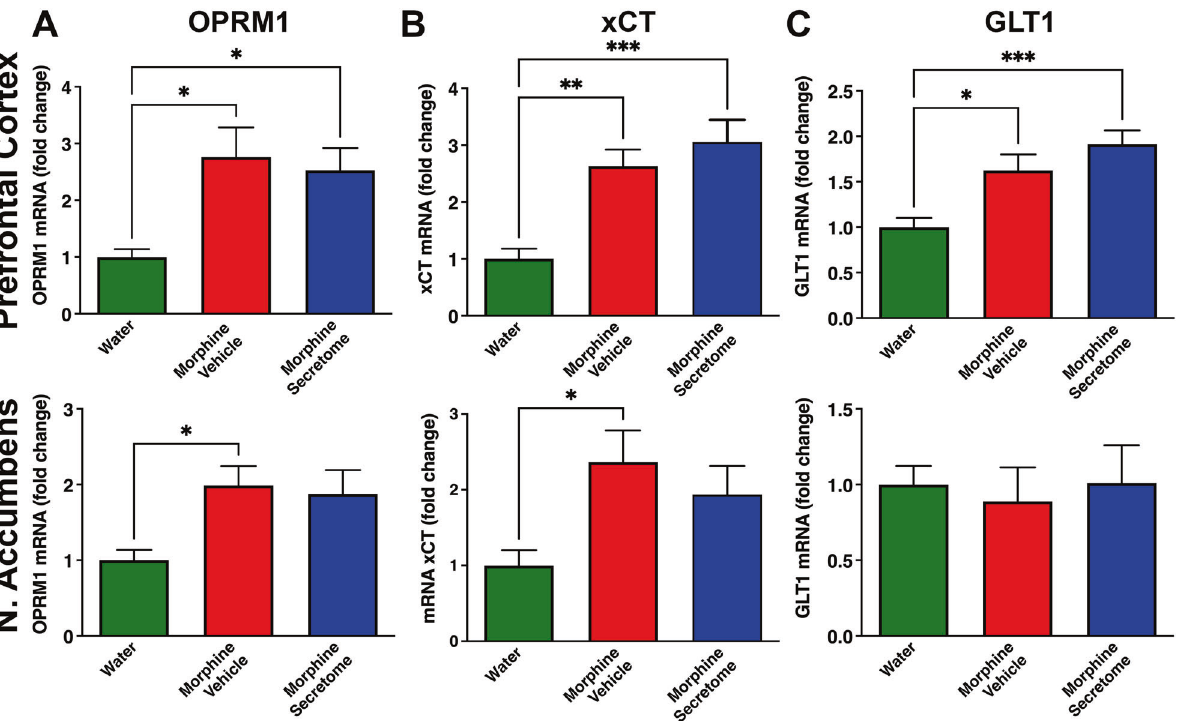
Fig. 3 Simultaneous intranasal and intravenous administration of secretome derived from human preconditioned MSCs to Wistar did not modify the morphine-induced increases in the brain expression of μ -opioid receptor or glutamate transporters. Quanti fi cation of the mRNA levels of the ( A ) μ -opioid receptor OPRM1; ( B ) xCT glutamate transporter and ( C ) GLT-1 glutamate transporter, determined by RT-qPCR in prefrontal cortex (top) and nucleus accumbens (bottom) of rats chronically drinking morphine, deprived for morphine for 12 days and allowed morphine re-access for 24 hours. Data were normalized against the mRNA level of the housekeeping gene GAPDH in the same sample. Morphine intake induced a signi fi cant increase in μ -opioid receptor mRNA levels in prefrontal cortex and nucleus accumbens (red bars in A ) (* p < 0.05, One-way ANOVA followed by Tukey ’ s post-hoc test), in xCT mRNA levels in prefrontal cortex and nucleus accumbens (red bars in B ) (* p < 0.05, ** p < 0.01 One-way ANOVA followed by Tukey ’ s post-hoc test), and in GLT-1 mRNA levels in prefrontal cortex (red bars in C ) (* p < 0.05, One-way ANOVA followed by Tukey ’ s post-hoc test), compared with water drinking animals (green bars). Simultaneous intranasal and intravenous administration of three secretome doses (on day 22 of the chronic morphine access and on days 2 and 9 of the